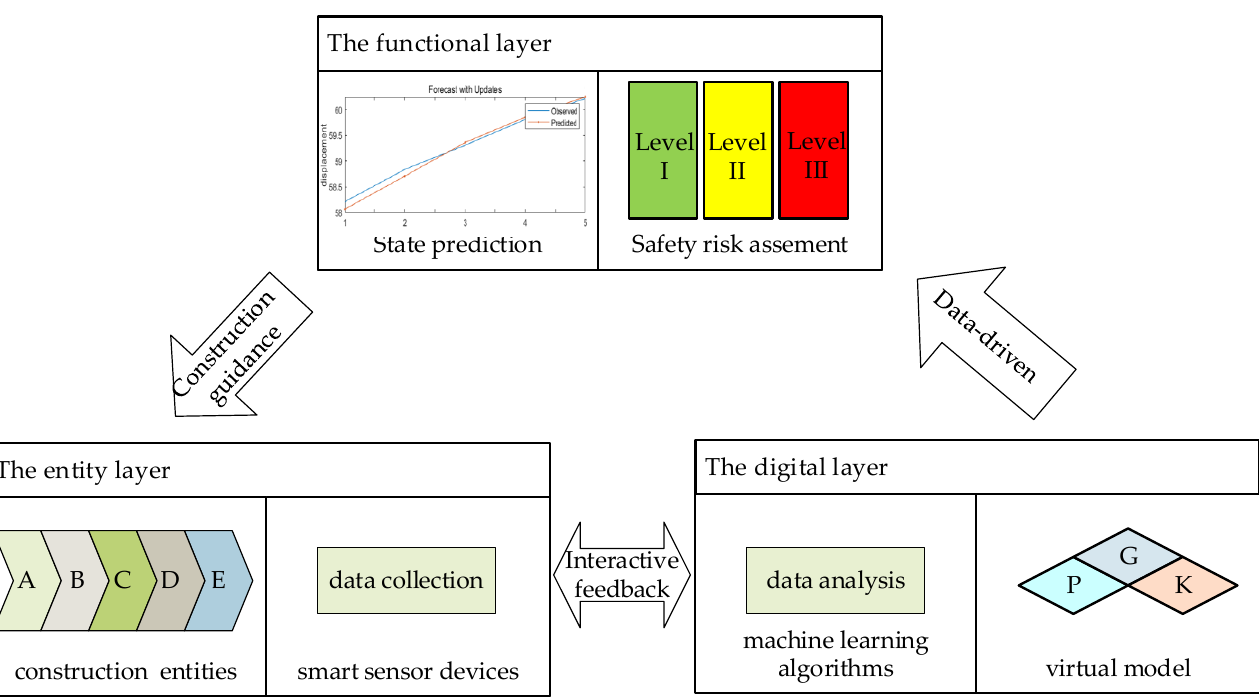
Figure 1. Construction safety risk assessment framework.